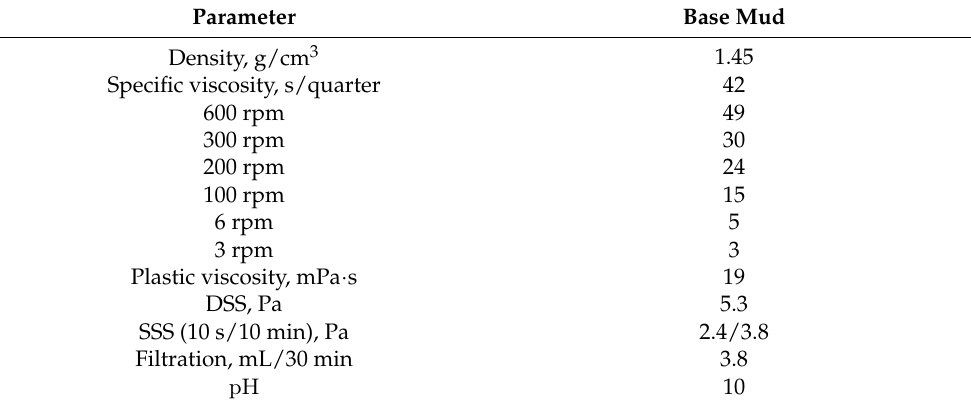
Table 2. Parameters of the formate base mud.